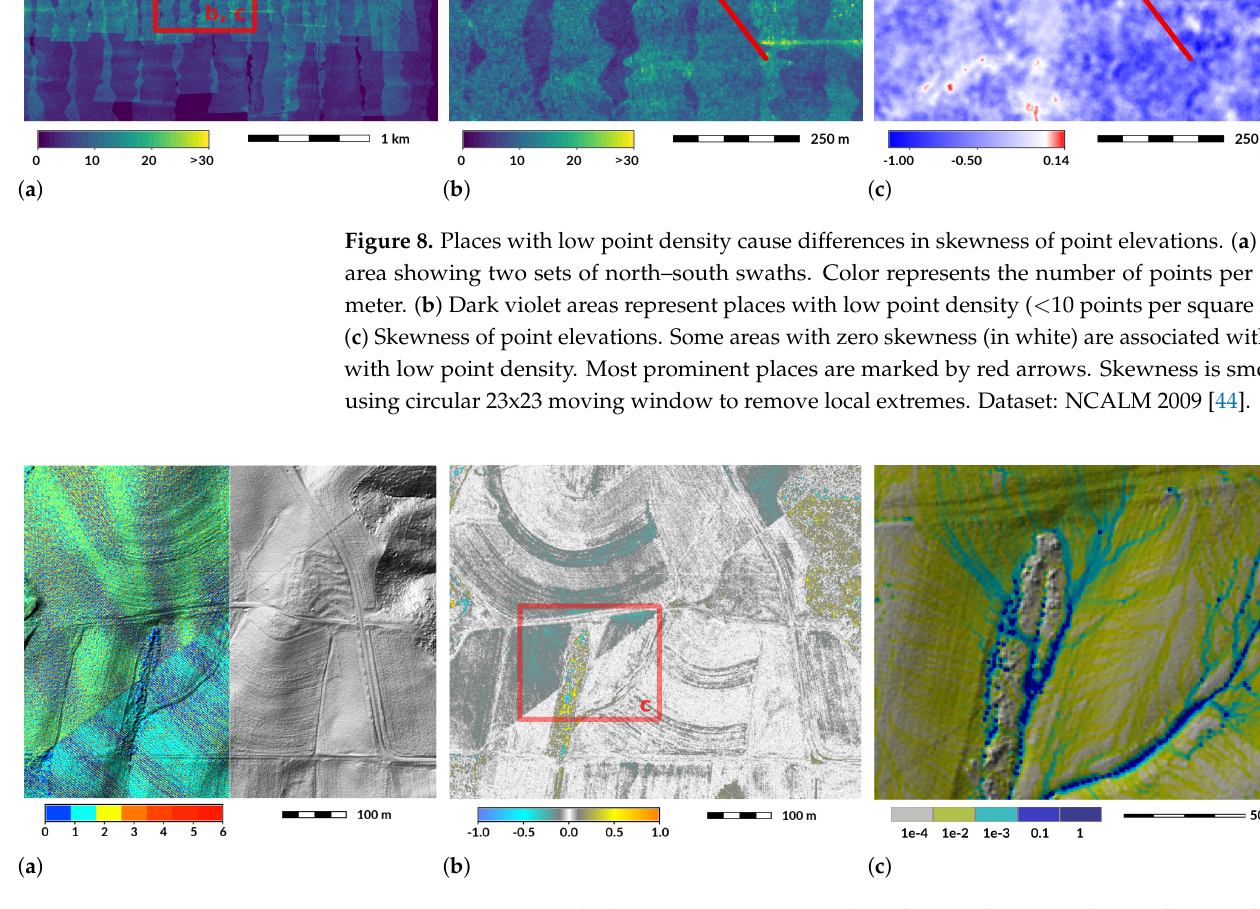
Figure 9. Error in swath elevation registration (a line close to the image diagonal): ( a ) Split view between point density and shaded relief (1 meter resolution, year 2013). ( b ) Elevation difference in meters; year 2015 minus year 2013. ( c ) Water discharge in m 3 s − 1 simulated by SIMWE [65] with default parameters. Datasets: Wake County 2013 [43], NC Floodplain Mapping Program 2015